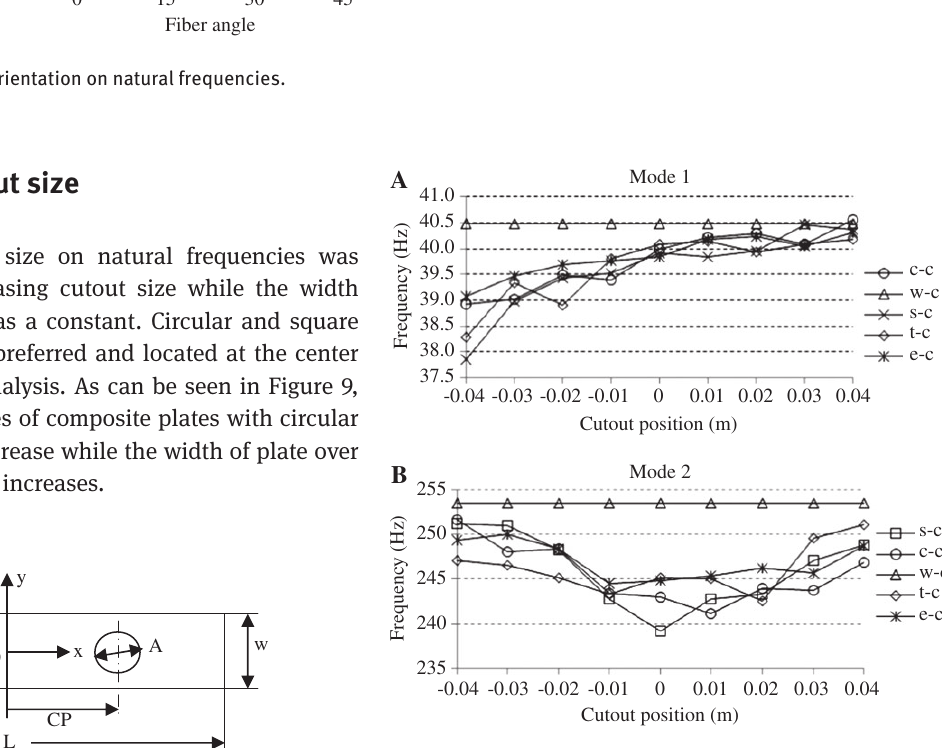
Figure 8 Change in cutout position for (A) first mode and (B) second